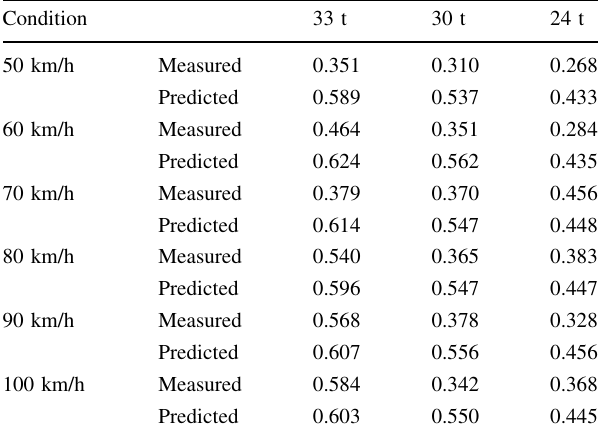
Table 4 Contrast of maximum acceleration of vehicle between measured and predicted values (Unit: m/s 2